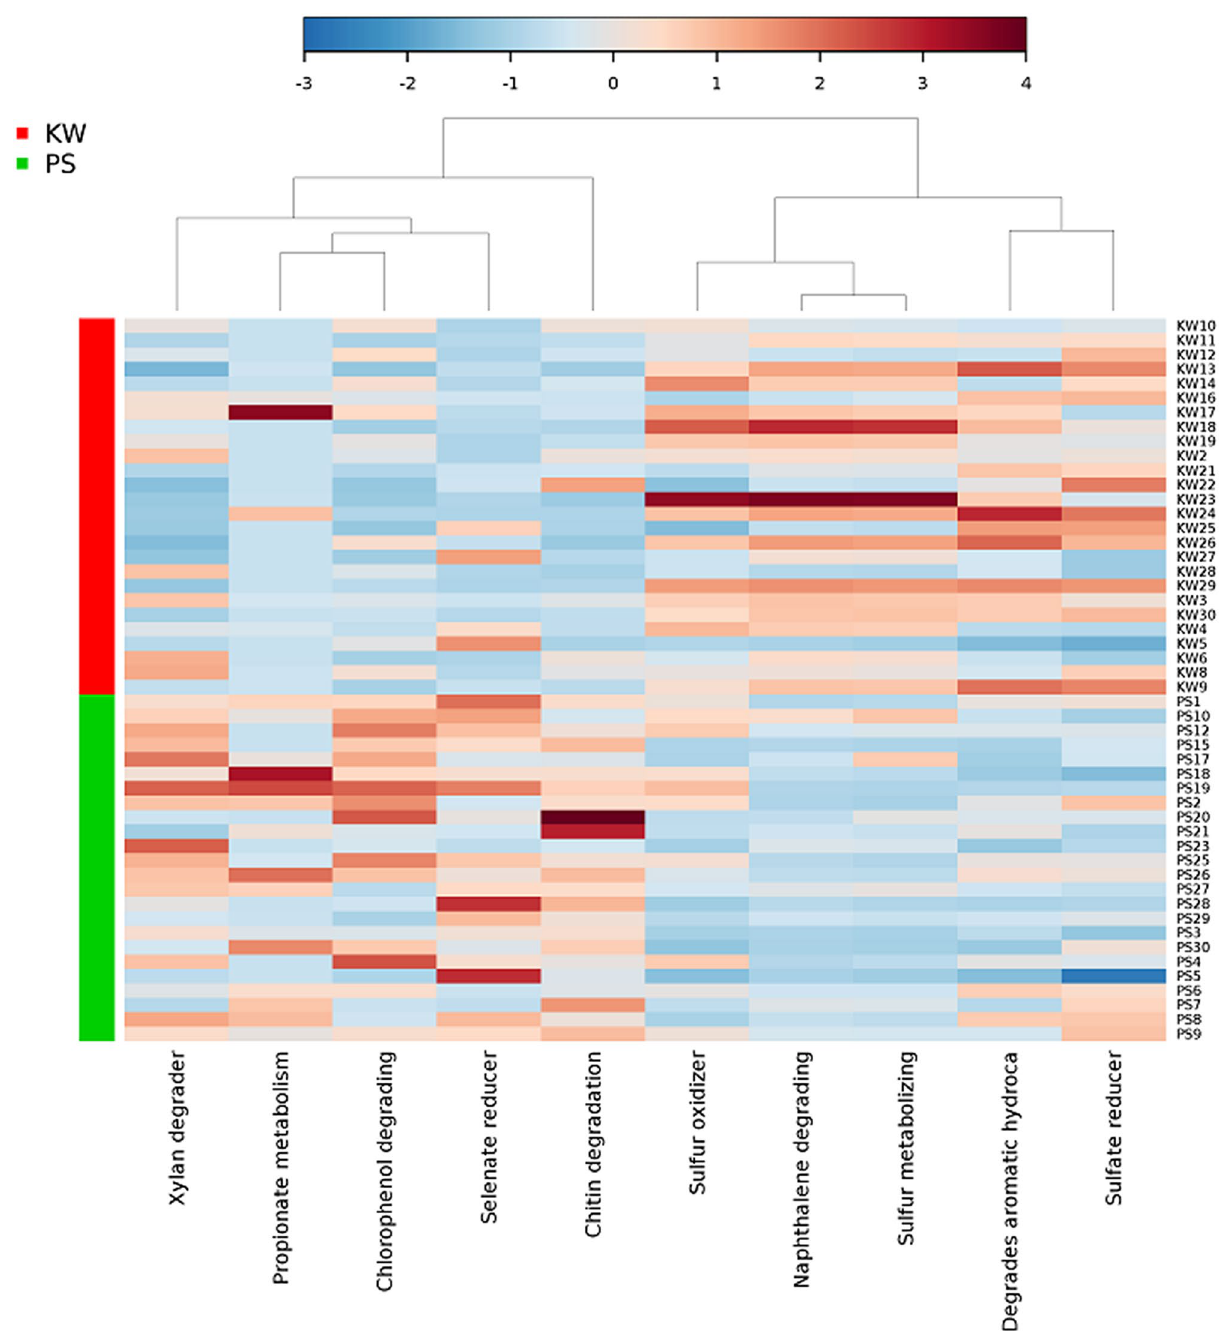
Figure 4. Taxonomic-based functional profiling of bacterial communities from permethrin-selected (PS) and parent strain (KW) of Aedes aegypti . Functional differences are shown on a relative scale with enrichment in red and depletion in